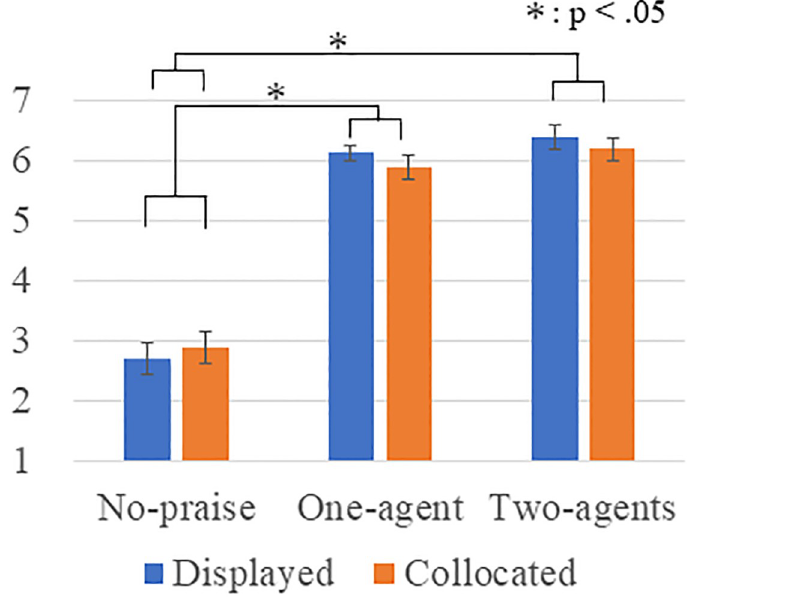
Fig 8. Degree of perceived